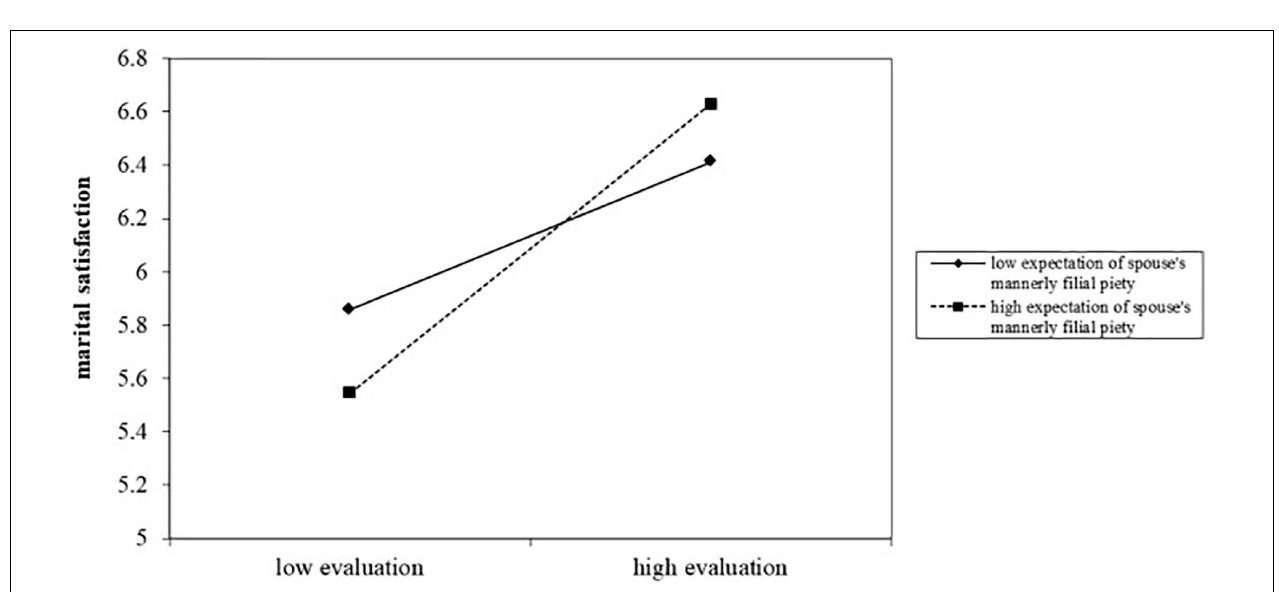
FIGURE 1 | The interaction effect of couple’s sibling condition on the evaluation of mannerly filial piety for male participants.